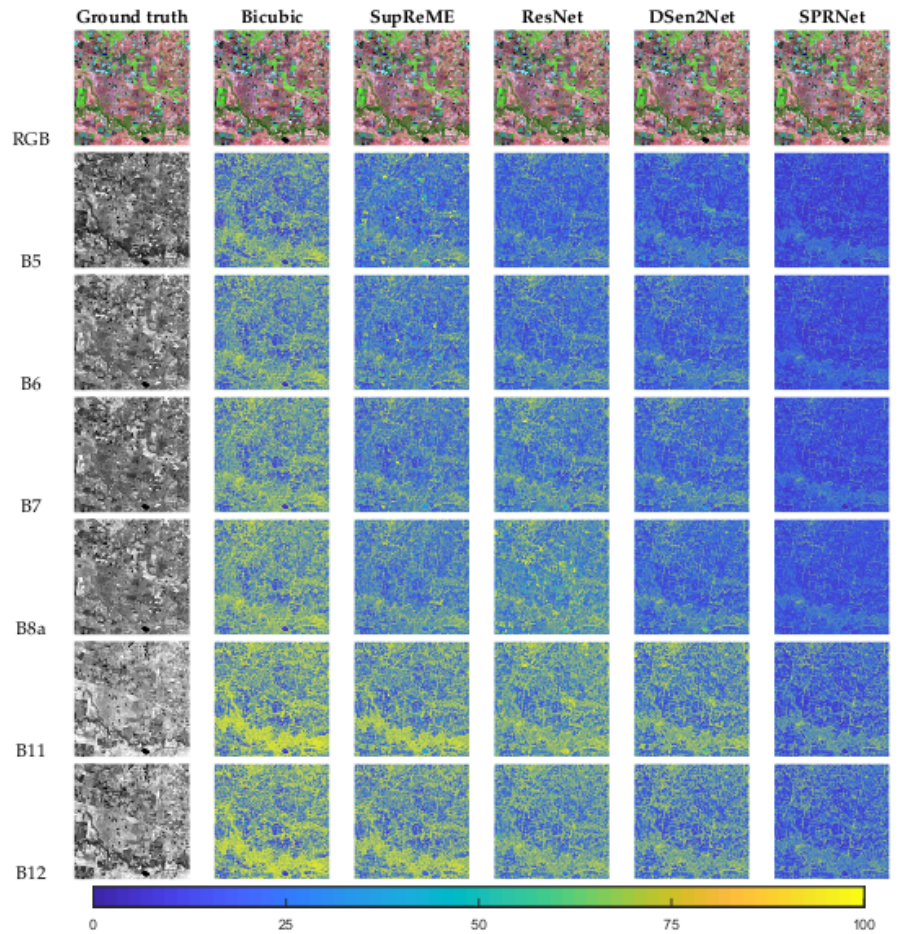
Figure 6. Absolute differences between ground truth and sharpening results on site 2 at lower scale (input 40 m output 20